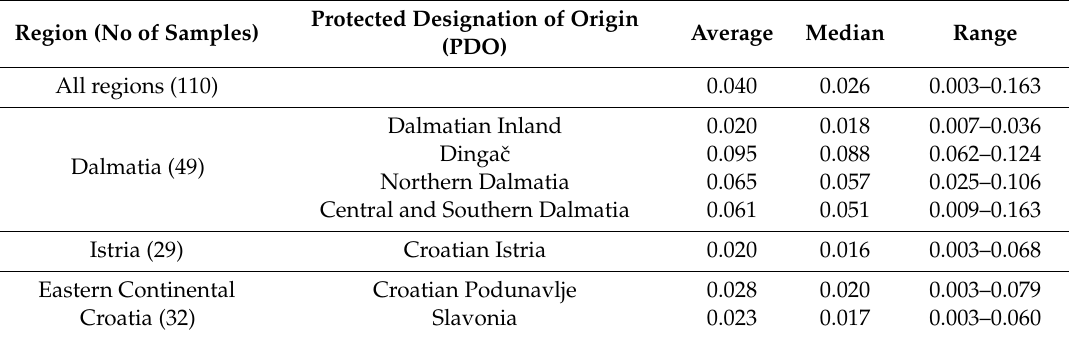
Table 3. Concentrations of ochratoxin A ( µ g / L) according to geographic origin.